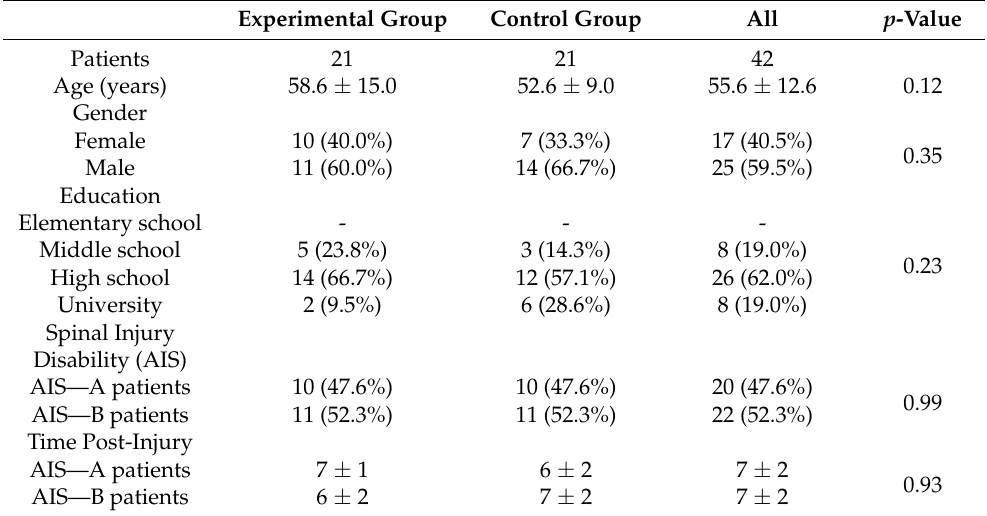
Table 1. Demographic and clinical characteristics of the patients. Mean ± standard deviation or numbers and percentages were used to describe the variables. Experimental Group Control Group All p